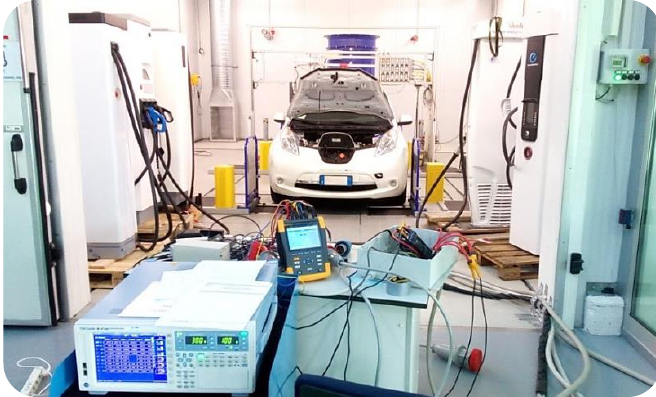
Figure 1. Fast-charging experiment implementation in the climatic chamber set-up.